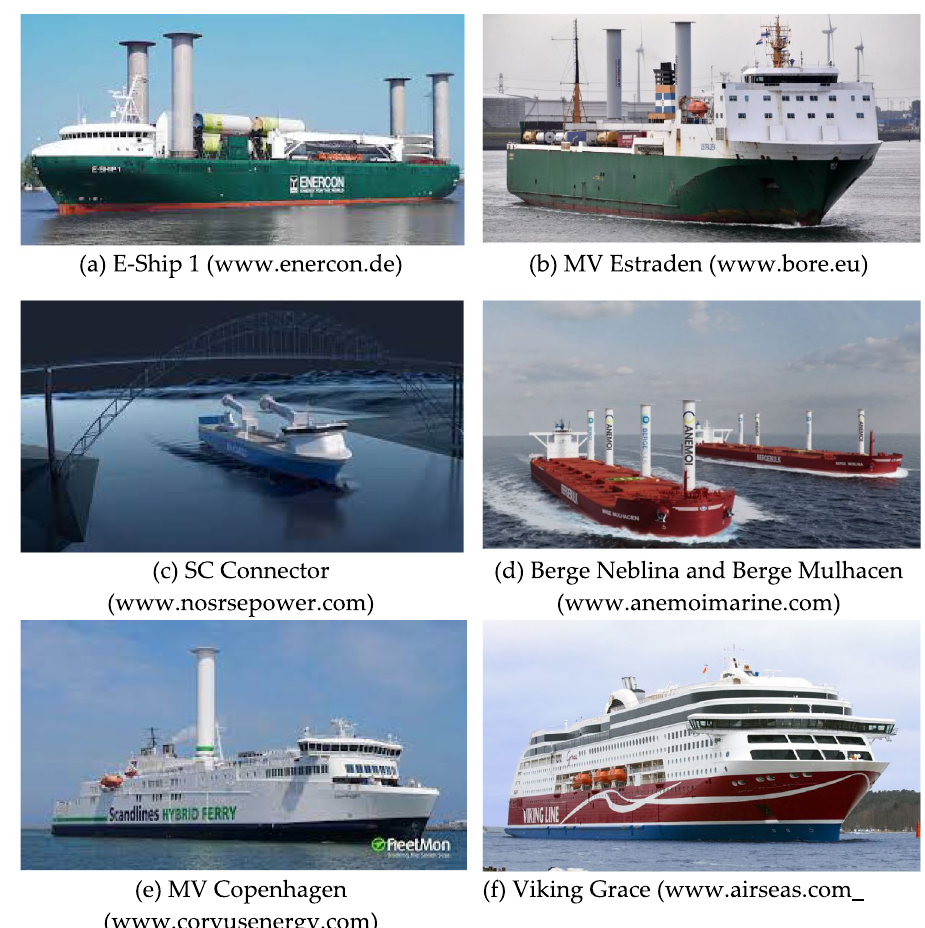
Fig. 6 Commercial ships equipped with Flettner